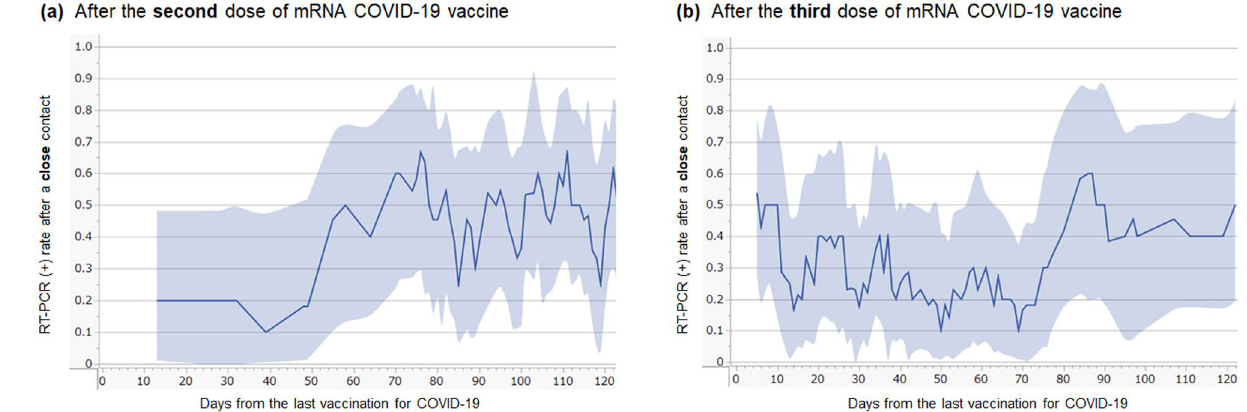
Figure 2. RT-PCR test-positive rate after close contact with COVID-19 cases by the time of the last vaccination. Line graphs for the RT-PCR test-positive rate after close contact with COVID-19 cases, according to the days of the last vaccination in those who completed two ( a ) or three ( b ) doses of mRNA COVID-19 vaccines are shown. The lines represent the rolling average of the test-positive rate within the nearby ± 5 days for each day relapsed from the last vaccination. The blue-filled areas above and below the line graphs represent the 95% confidence interval of the test-positive rate. COVID-19, coronavirus disease 2019; mRNA, messenger RNA; RT-PCR, reverse transcription-polymerase chain